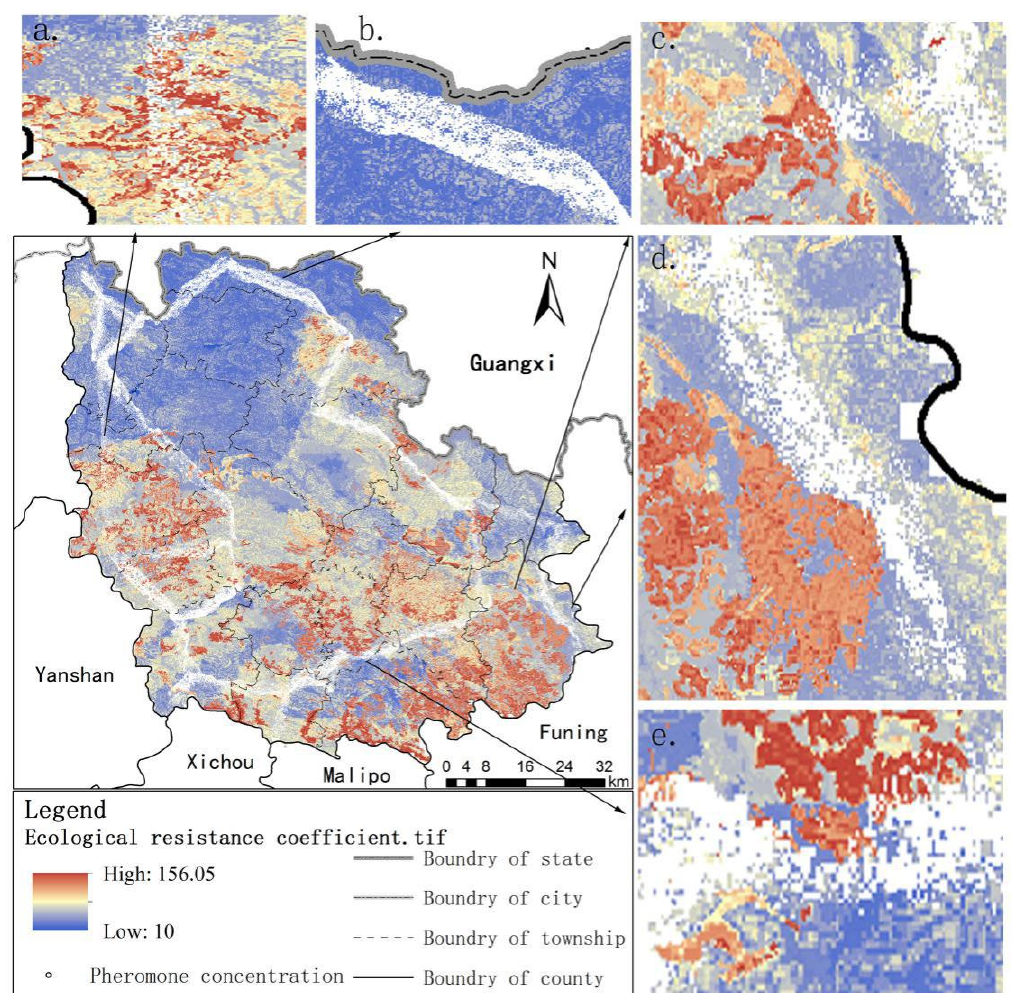
Figure 7. Spatial distribution of pheromone in Ant algorithm. ( a – e ) The ecological corridor is located in the same resistance value, and the pheromone concentration presents different characteristics in space.